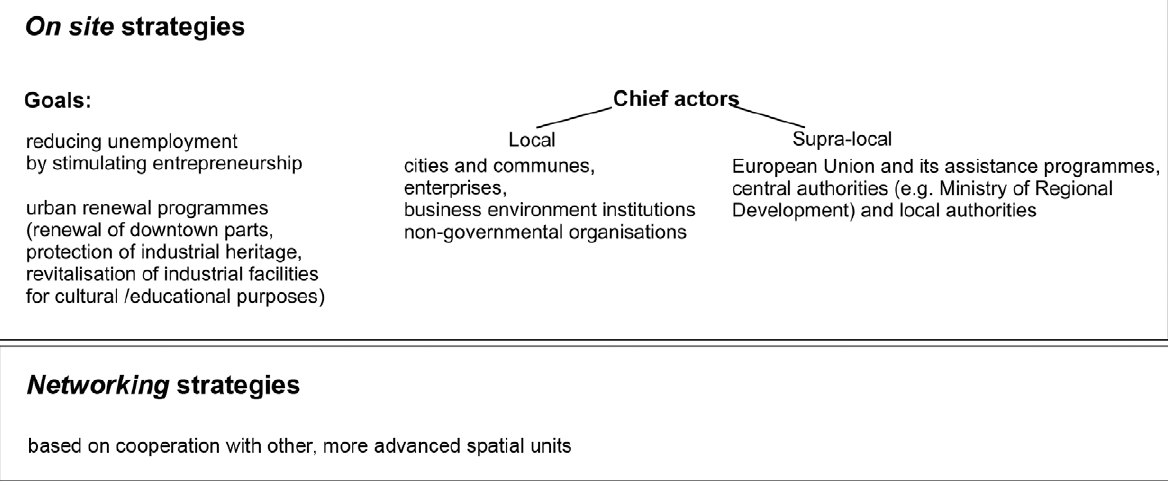
Fig. 3. Two strategic orientations intended to counteract the adverse effects of urban shrinkage. Source: own